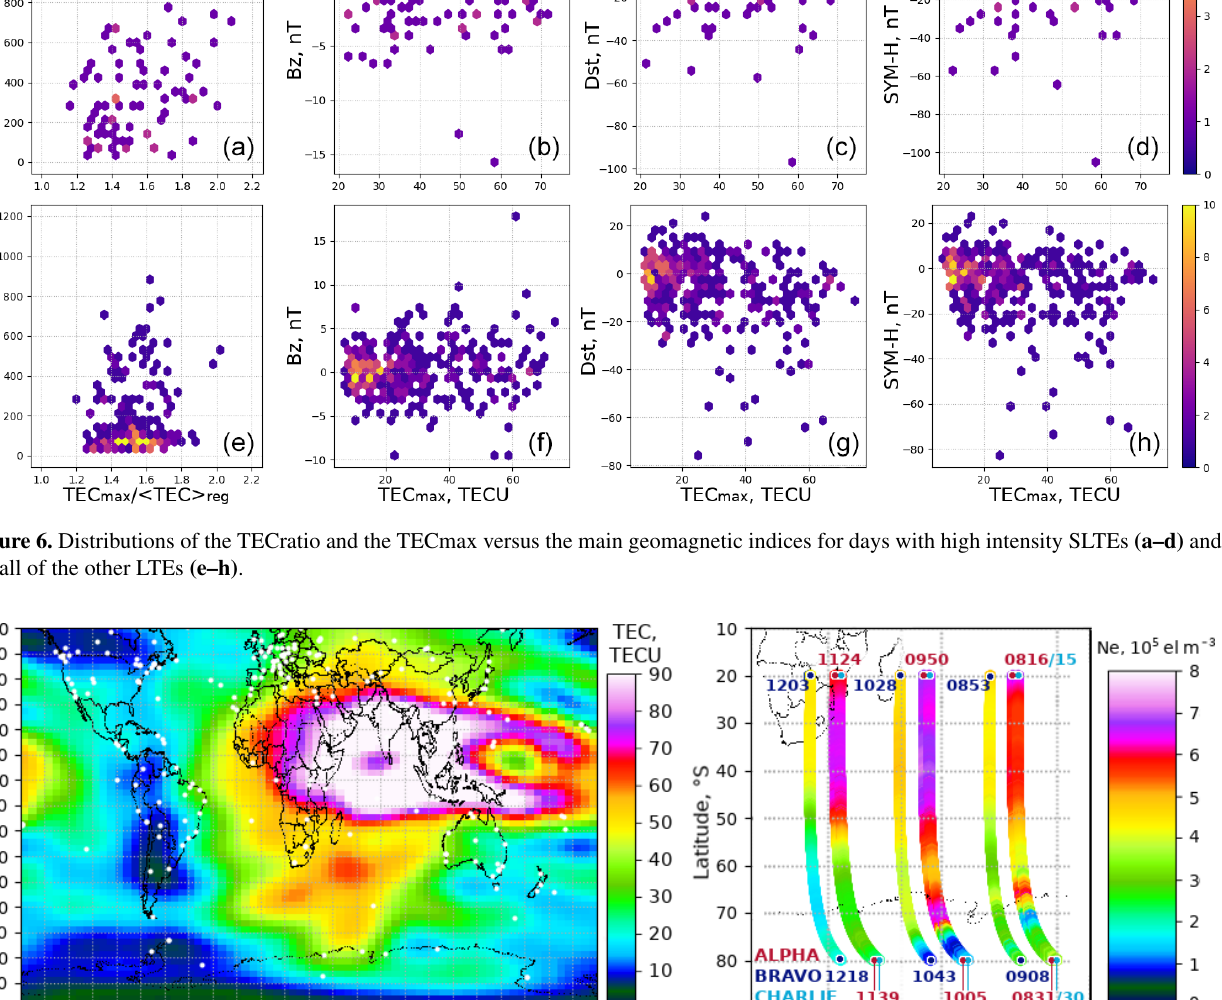
(460 km) and Bravo (530 km) satellite orbits. This, combined with the data shown in Fig. 2, makes a strong case for the fact that LTEs of both types (MLTE and SLTE) are predominantly located in the F2